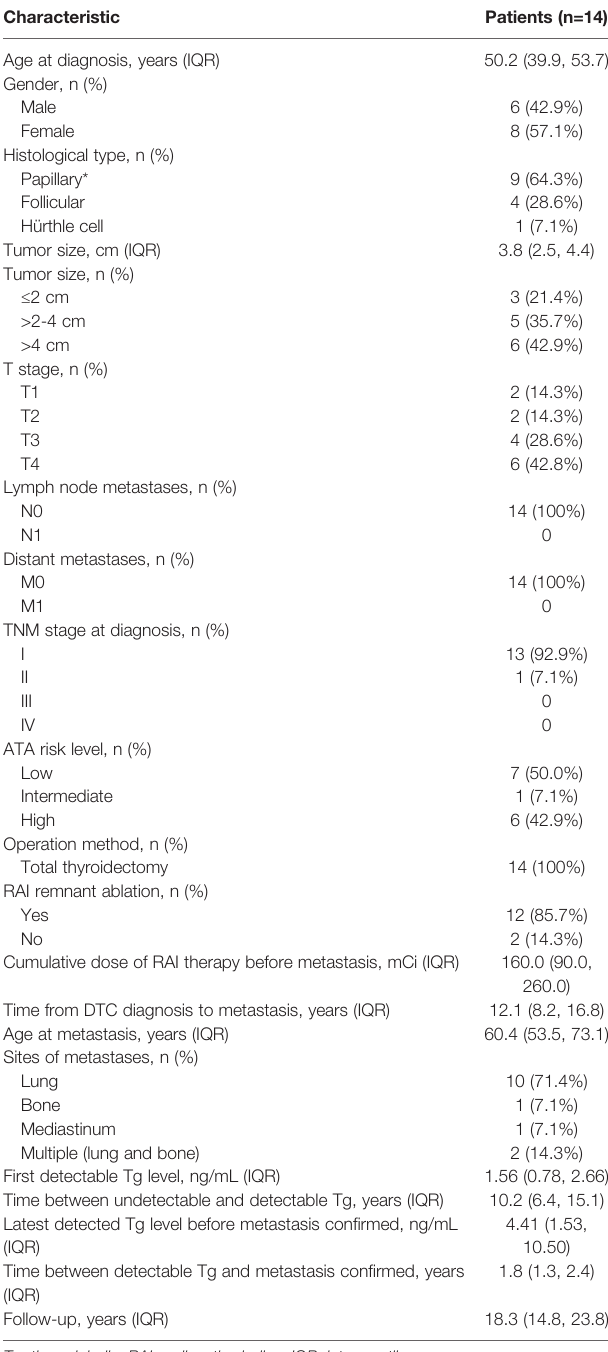
TABLE 1 | Clinical features of 14 patients with excellent response after initial therapy and developed metastatic disease during follow-up.